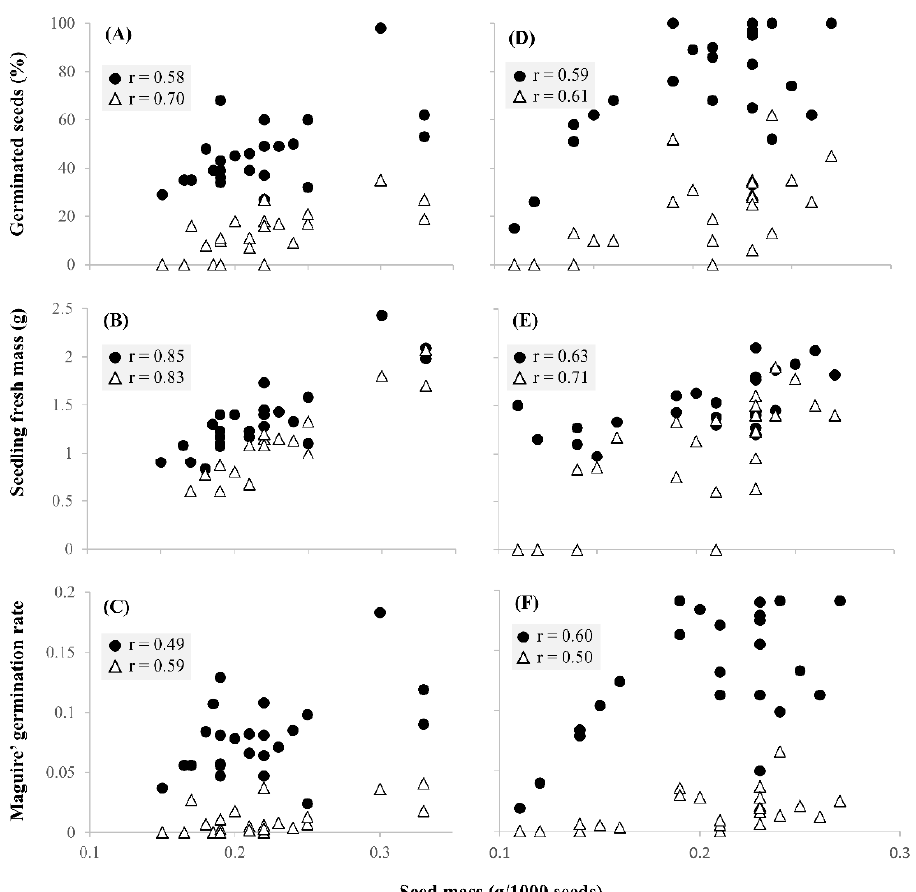
Figure 2. Correlation coefficients (r) of seed weight under osmotic stress (white triangles) and control conditions (black circles) with: ( A ) final emergence percentage (FEP), ( B ) seedling fresh mass (SFM) and ( C ) Maguire’ germination rate (GR) in Leptochloa crinita . Correlations of seed weight under osmotic stress and control conditions with: ( D ) FEP, ( E ) SFM and ( F ) GR in Leptochloa pluriflora .